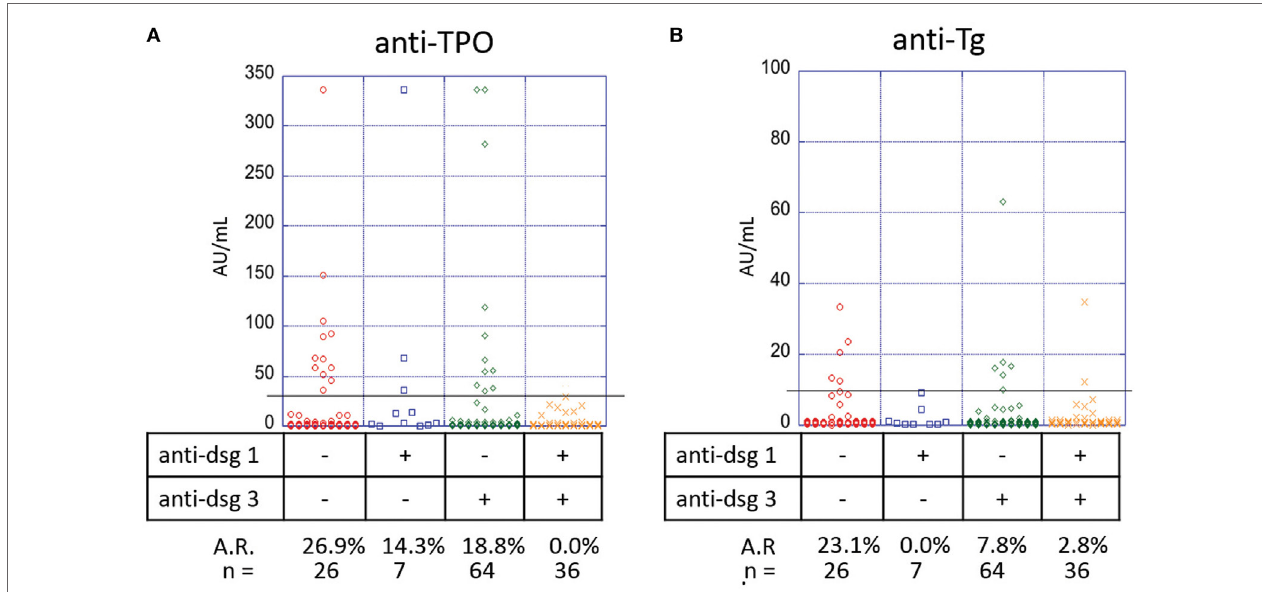
FigUre 6 | Correlation of anti-thyroid peroxidase (anti-TPO), anti-thyroglobulin (anti-Tg), with anti-Dsg3/1 levels in pemphigus vulgaris (PV) patients with active lesions. Levels of (a) anti-TPO and (b) anti-Tg antibodies in PV patients, subgrouped on the basis of presence or absence of anti-Dsg3 and or anti-Dsg1 antibodies. Individual dots represent anti-TPO and anti-Tg levels (in AU/ml). Anti-TPO and anti-Tg antibody rates were modeled as a function of absence or presence of anti-Dsg3/1 serum antibodies using a generalized estimating equations logistic regression